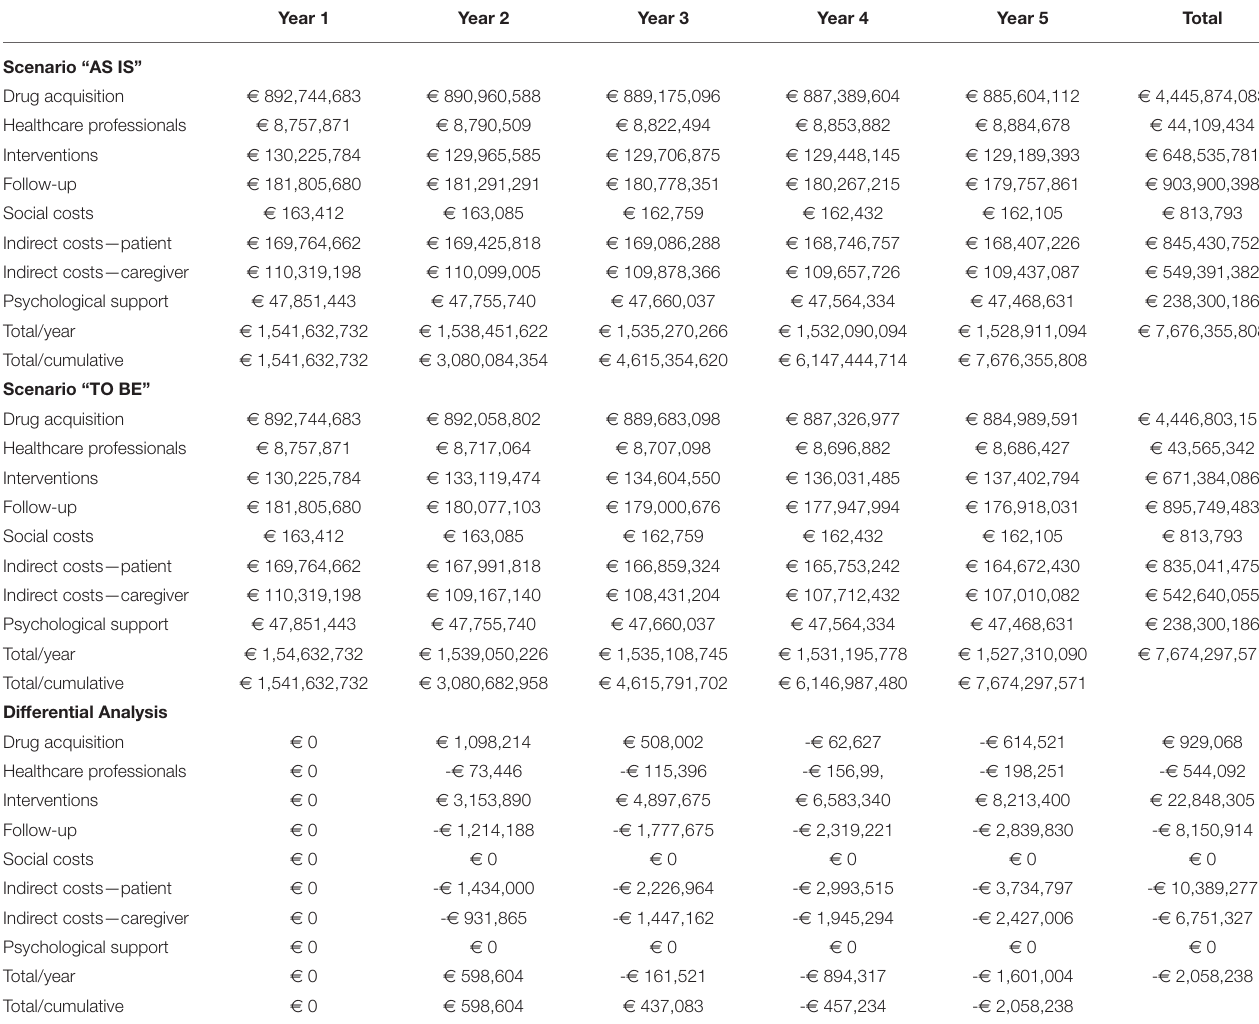
TABLE 4 | Resource absorption: “Scenario AS IS”, “Scenario TO BE” and differential